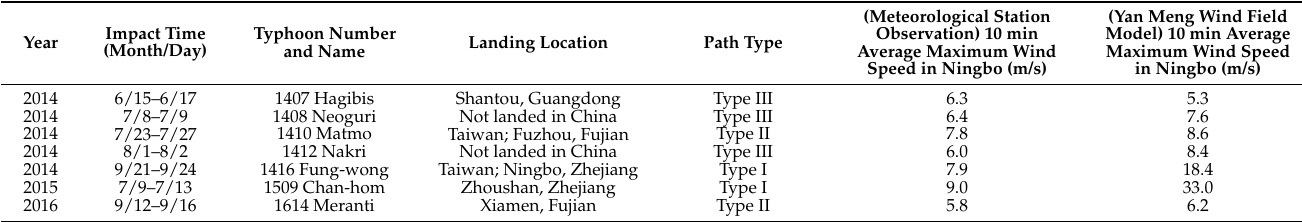
Figure 5. Schematic diagram of the activating wind field model. Table 1. Specific characteristics of 25 typhoons affecting the Ningbo